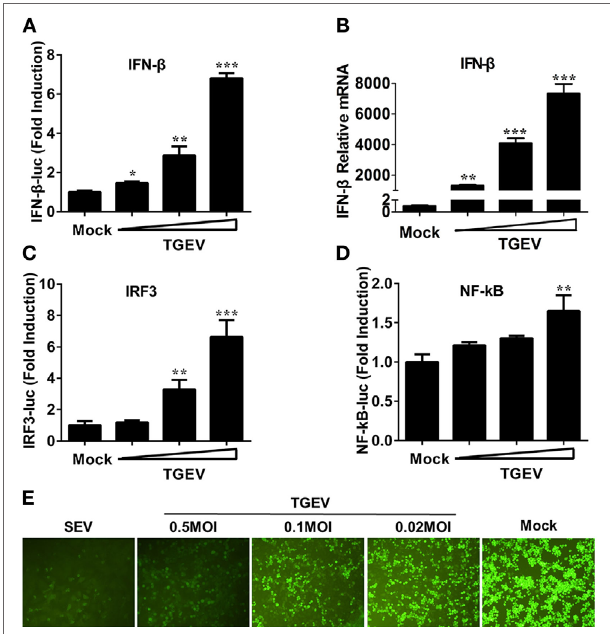
FigUre 1 | Transmissible gastroenteritis virus (TGEV) dose-dependently triggers activation of the IFN- β signal pathway and suppresses the replication of VSV. PK-15 cells were cotransfected with pRL-TK and IFN- β -Luc (a) , IRF3-Luc (c) , or NF- κ B-Luc (D) , followed by infection with increasing doses of TGEV [multiplicity of infection (MOI) = 0.02, 0.1, or 0.5] at 12 h post- transfection. The cells lysates were collected for dual luciferase assays at 24 hpi. (B) PK-15 cells were infected with TGEV as described in panel A and harvested at 24 hpi. Cell RNAs were extracted for RT-qPCR to examine the mRNA expression levels of IFN- β . The mRNA expression levels were normalized to porcine GAPDH transcripts. Values are the mean ± SD of three independent tests. * P < 0.05, ** P < 0.01, or *** P < 0.001 compared with the mock infection group. (e) PK-15 cells were infected or mock infected with TGEV (MOI = 0.02, 0.1, 0.5). The supernatants were collected for UV-irradiation and then transferred onto fresh PK-15 cells, followed by infection with vesicular stomatitis virus expressing green fluorescent protein (VSV-GFP) at 24 h later. Cells were observed with fluorescence microscope at 16 hpi. The supernatants from SEV-treated cells served as a positive